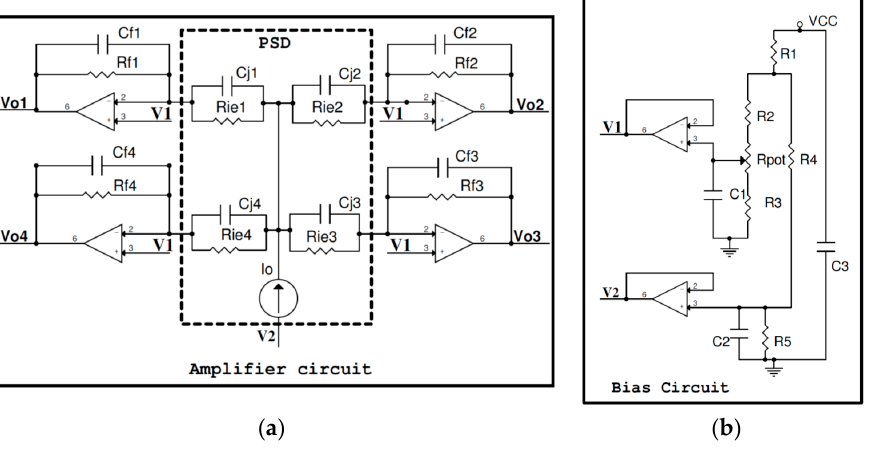
Figure 4. Schematic diagram of the electronic system to handle the PSD sensor ( a ) Amplifier circuit; ( b ) Bias circuit.